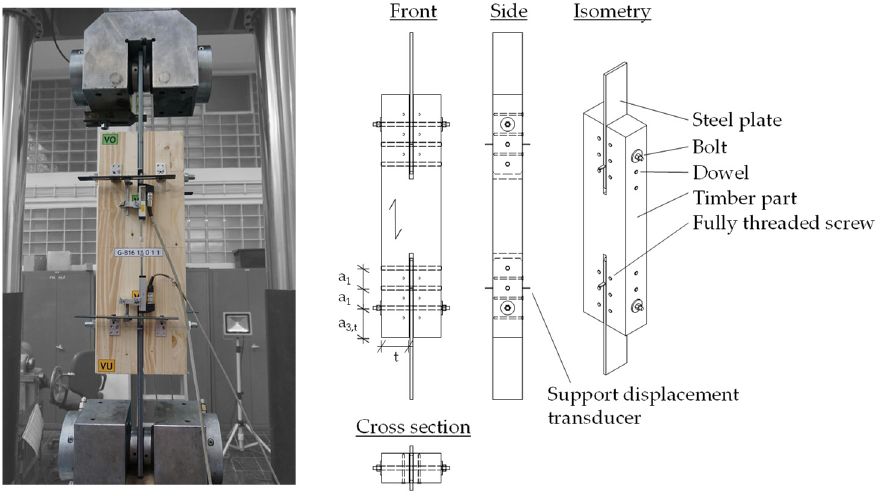
Figure 8. Example of the test setup for the tensile tests (left) [34], and of a specimen for tensile test parallel to grain with 1 × 3 fasteners (right) [29].